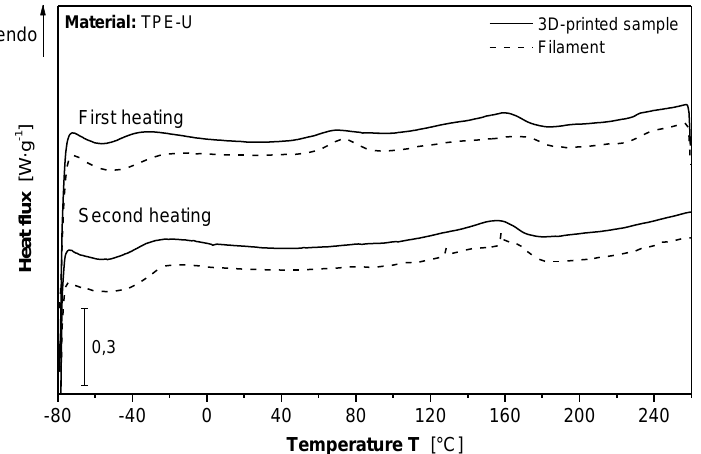
Figure 7. DSC-curves of filament and 3D printed specimen type 5 A according to ISO 527. Figure 8 represents the force displacement curve of the TPU filament under tensile loading. The strength of the filament is about 30 MPa at a filament diameter of 1.8 mm, which was tested, and the strain at break is about 450%.